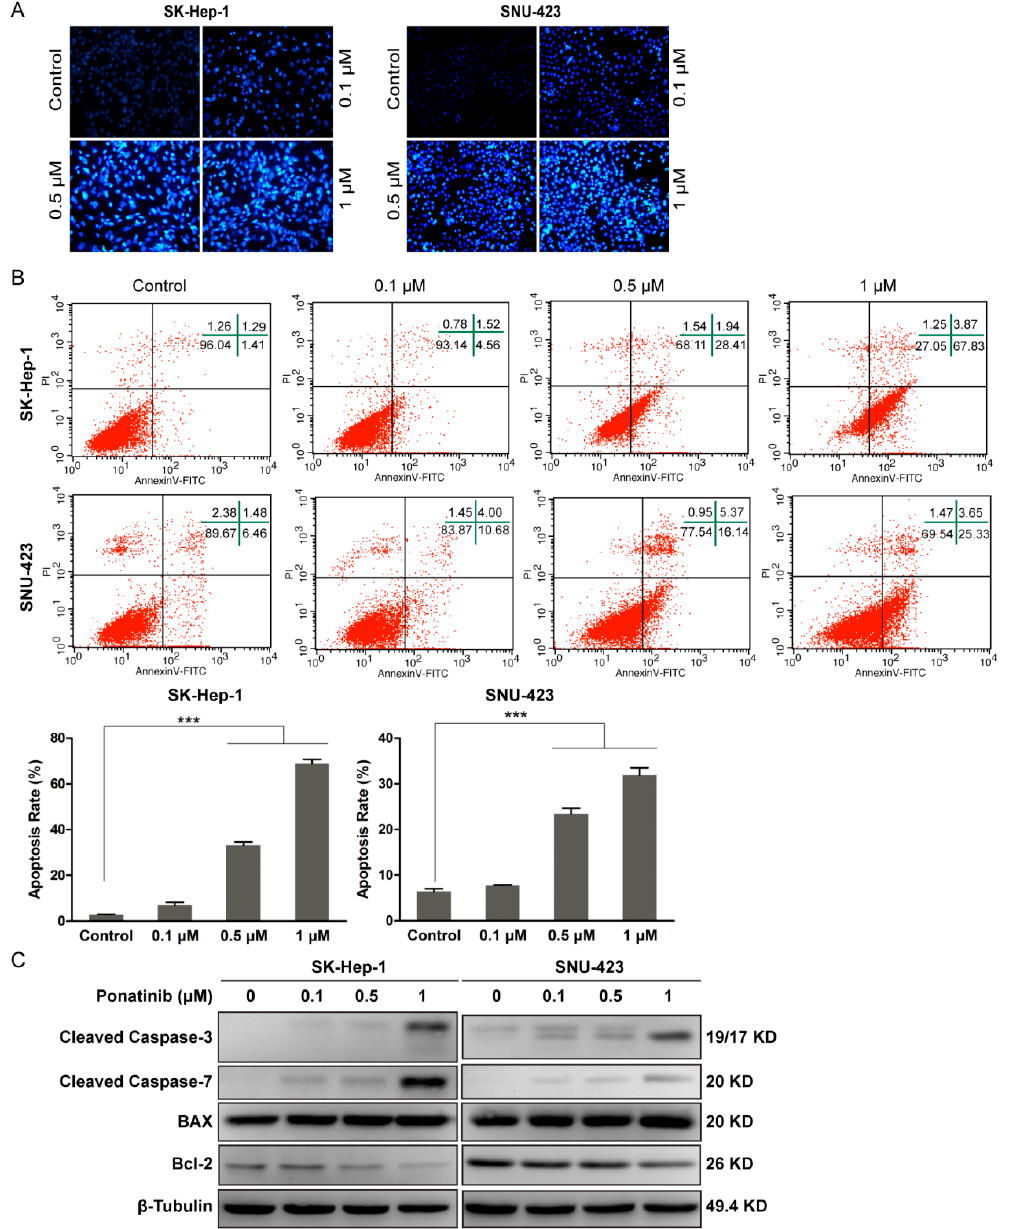
Figure 2. Ponatinib induced cell apoptosis in SK-Hep-1 and SNU-423 cells in